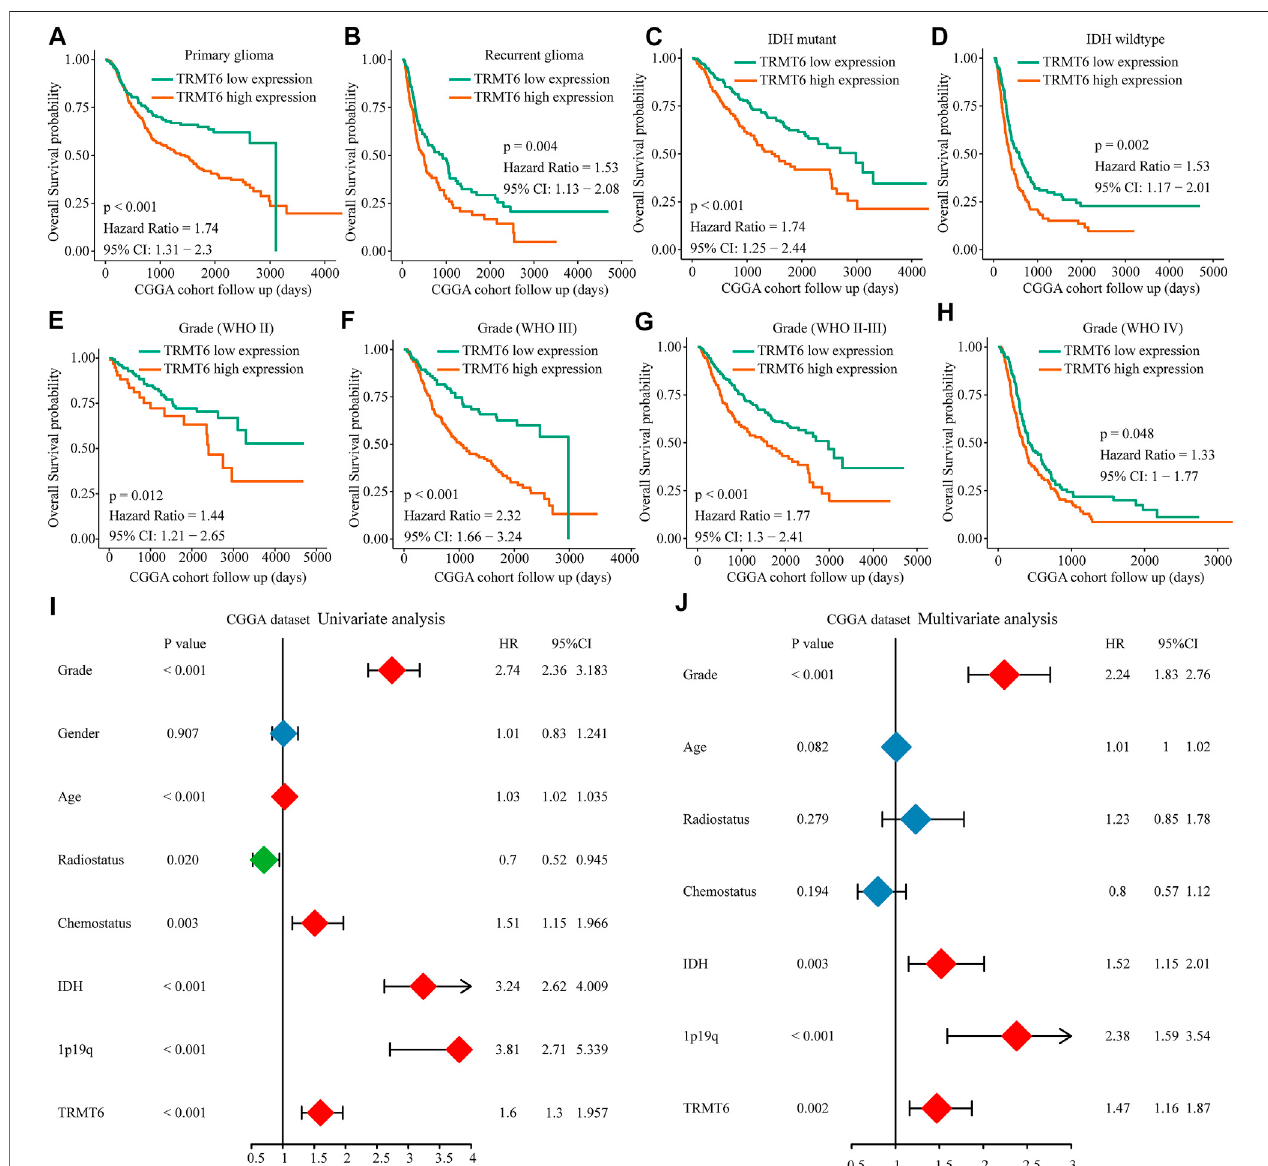
FIGURE 4 | Prognostic value of the TRMT6 in glioma. (A – H) Kaplan – Meier overall survival curves of TRMT6 for patients in the CGGA dataset strati fi ed by recurrence, WHO grade and IDH mutation statuses. (I – J) Univariate and multivariate Cox regression analyses showed that TRMT6 was an independent prognostic risk factor in CGGA